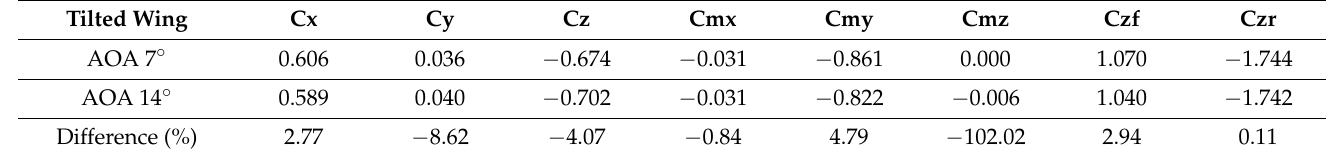
Table 3 contains numerical data of forces and coefficients obtained at velocity 30 m/s. Table 3. Parameters of the car with tilted wing at two angles of Table 3. Parameters of the car with tilted wing at two angles of attack.